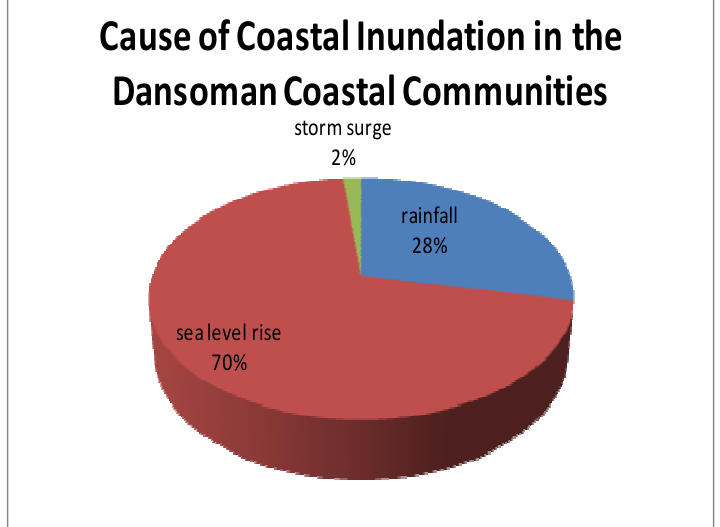
Figure 6. Causes of inundation in the study